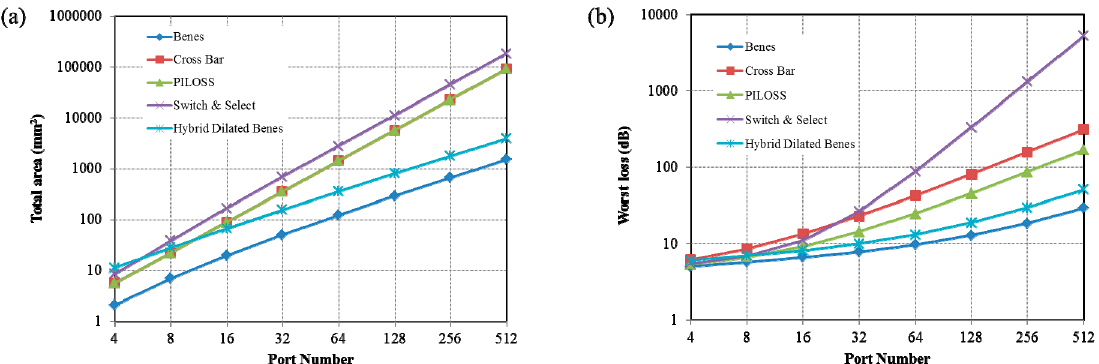
Figure 6. Switch matrix of different topologies ( a ) total area ( b ) insertion loss.